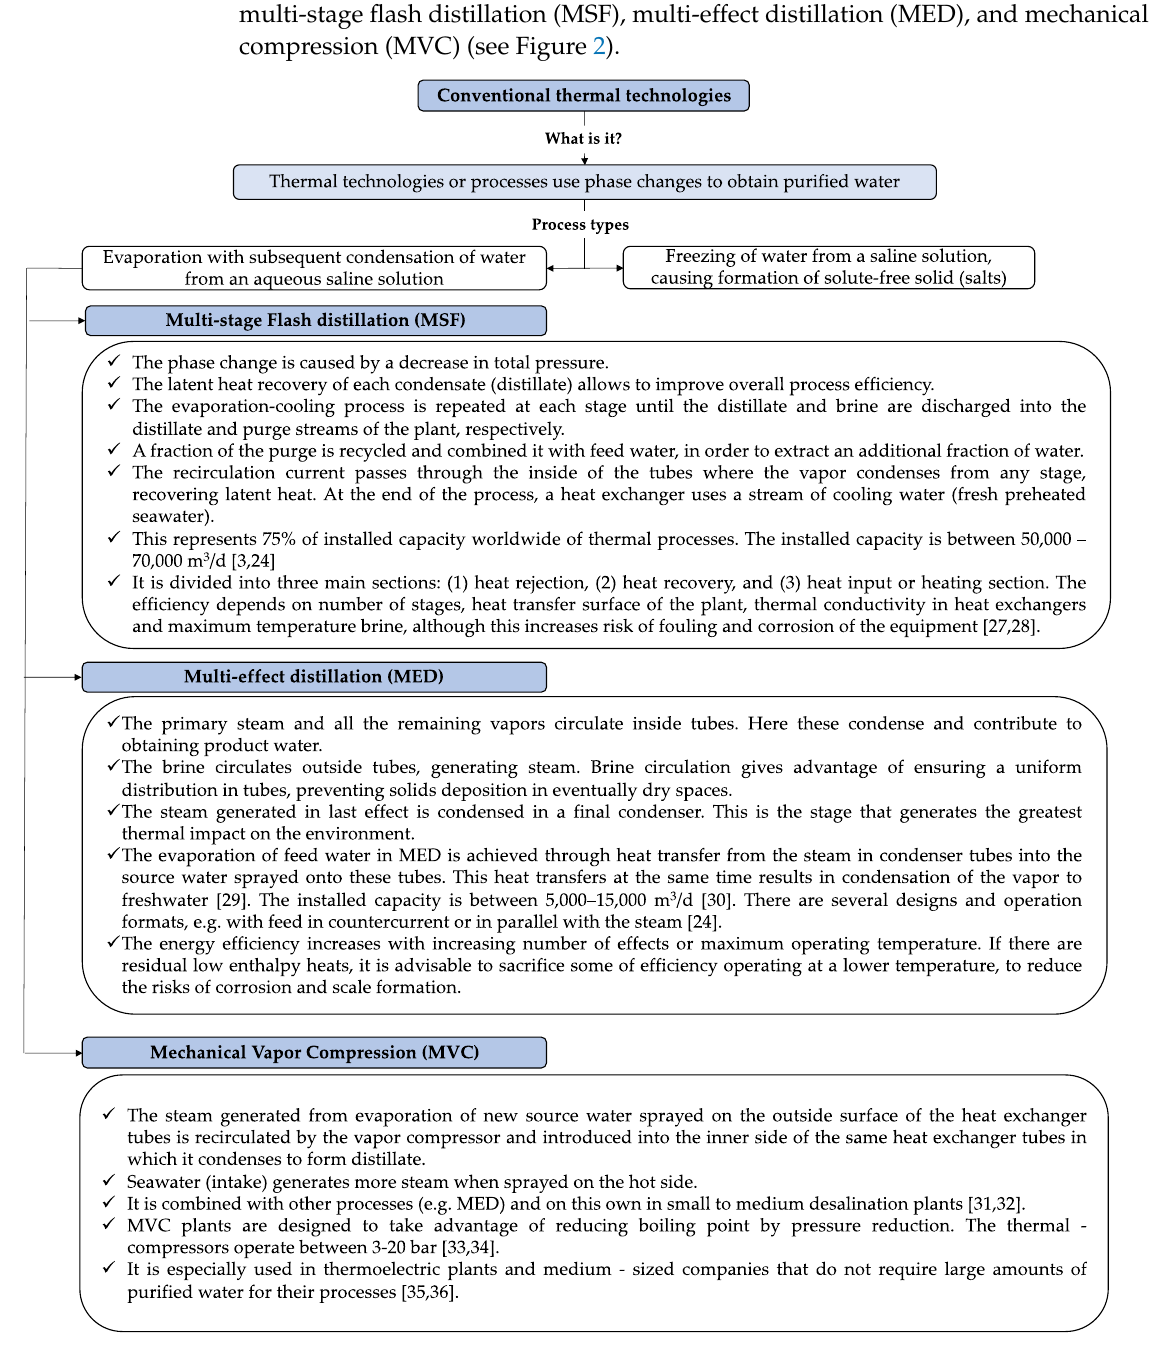
Figure 2. Conceptual diagram of the conventional thermal desalination technologies (Mentioned references [3,24,27–36]).